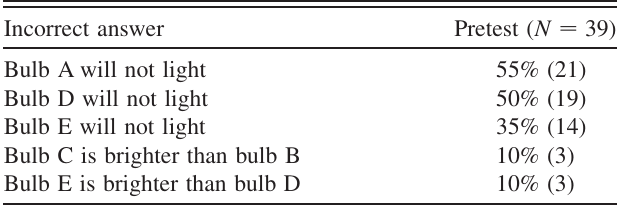
TABLE I. Common incorrect answers to multiple batteries in series pretest question of Fig. 2.